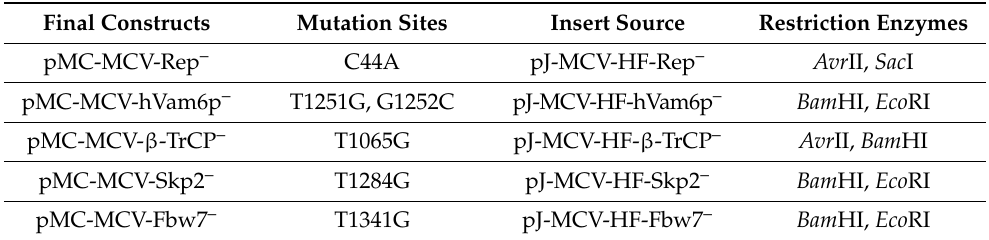
Table 1. Construction summary of pMC(minicircle)-MCV (Merkel cell polyomavirus) harboring